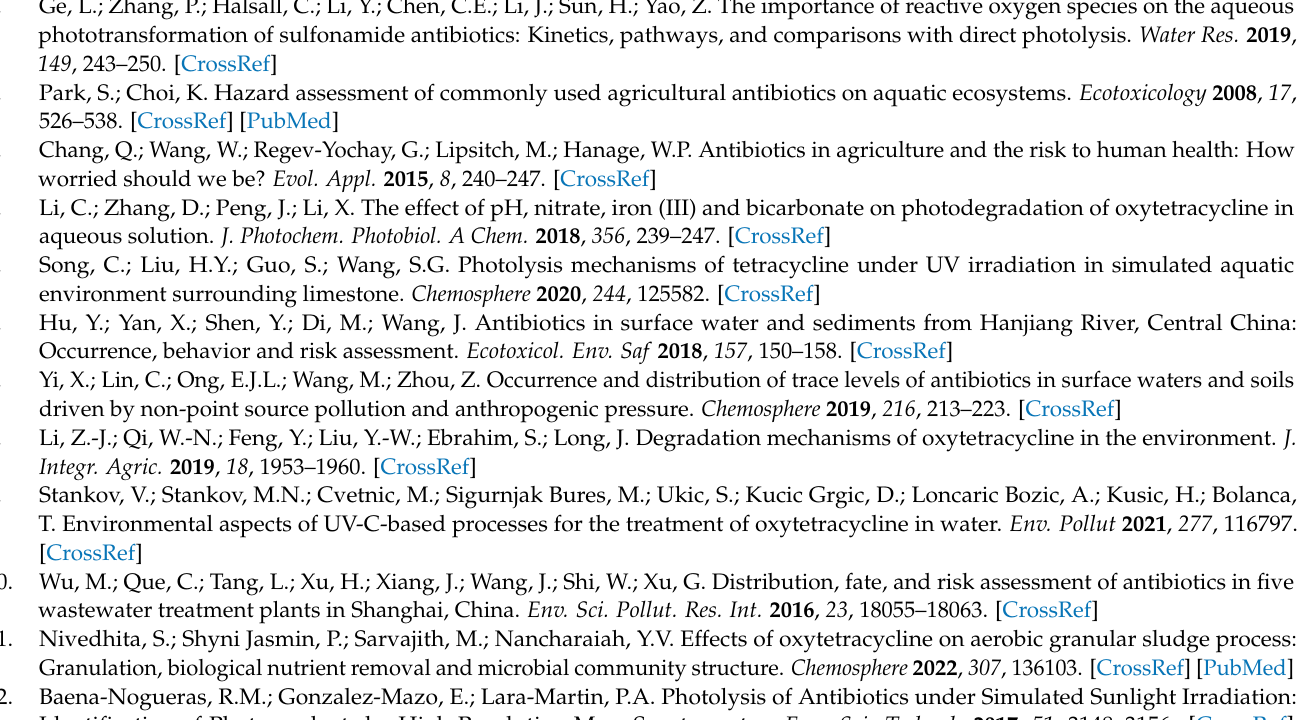
Table S2: Determined molar extinction coefficients of the four agricultural